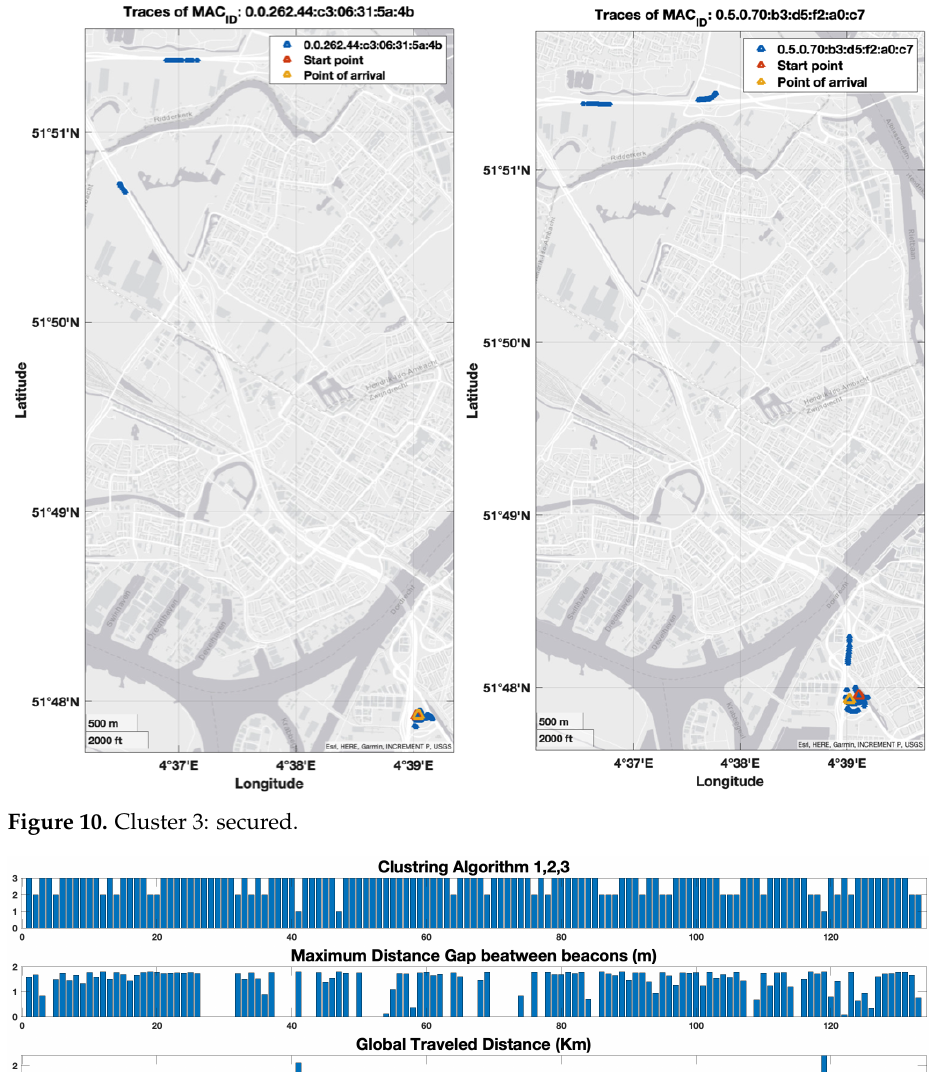
Figure 10. Cluster 3: secured.